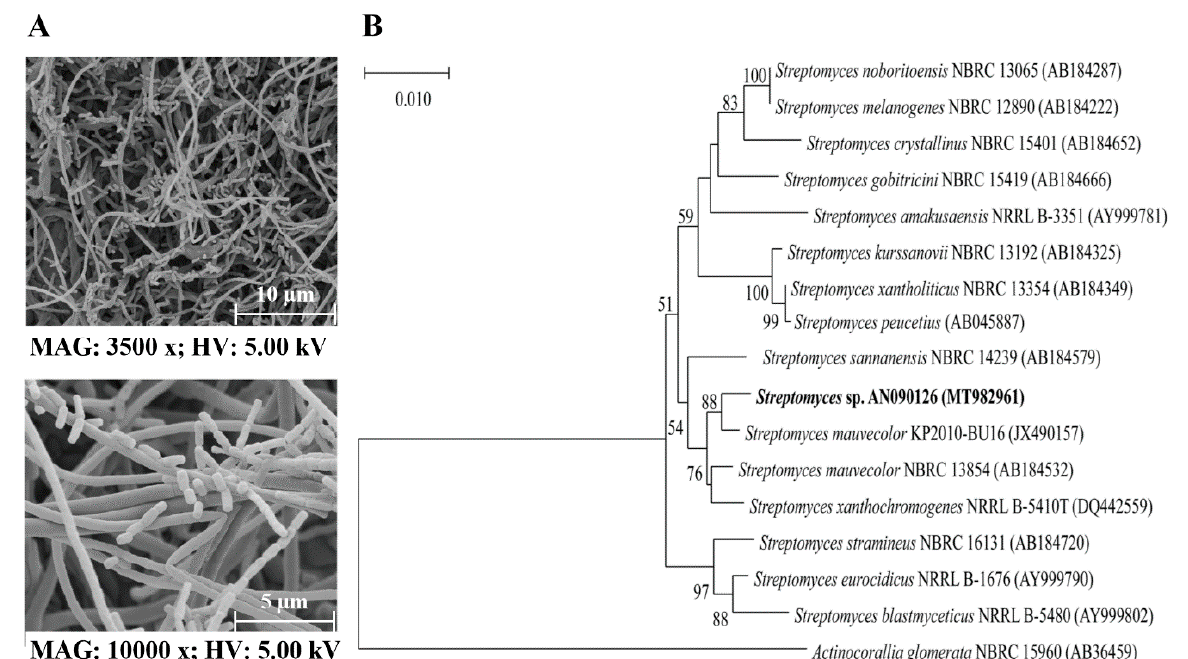
Figure 1. Taxonomy of Streptomyces sp. AN090126 based on phylogenetic and morphological characteristics. Scanning electron micrographs (3500× and 10,000×) of the spore morphology of Streptomyces sp. AN090126 in IPS medium at 30 °C for 7 days, which showed the aerial hyphae of AN090126 strain were non-fragmented and most spores were rod-shaped with a fragmented spore chain and rough surface ( A ). The phylogenetic relationships between Streptomyces sp. AN090126 (MT982961; 1474 bp) and other members of genus Streptomyces based on 16S rRNA gene sequences ( B ). The tree was constructed with the neighbor-joining method using the Jukes–Cantor model. The number on the branch points are bootstrap values from 1000 replications. Accession numbers given in the parentheses. Micromonospora inyonensis DSM 46123 T was used in the outgroup comparison. The scale bar of 0.010 substitutions per site.